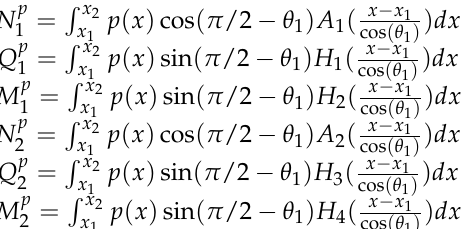
Figure 2. Free body diagram.